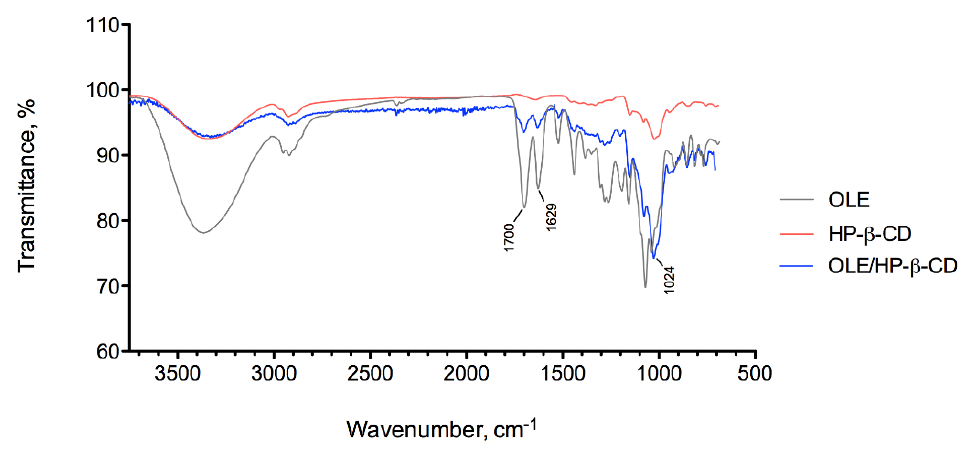
Figure 2. ATR-FTIR spectra of OLE, HP- β -CD, and OLE/HP- β -CD co-precipitate using a mac- ro-ATR accessory with a diamond crystal.